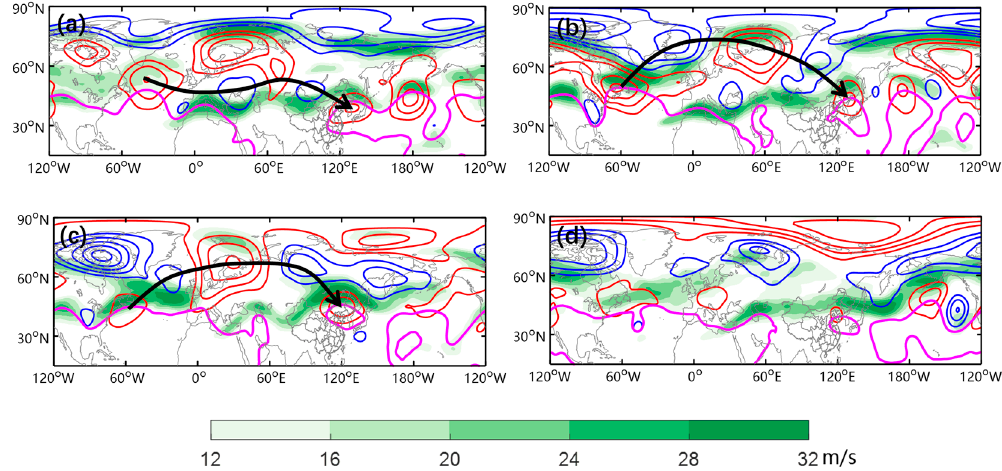
Figure 4. Composite 500 hPa geopotential height anomalies (contours; interval = 40; units: gpm), 300 hPa zonal wind (shading; units: m/s), 5880 gpm isoline (pink) for ( a ) hot period 1, ( b ) hot period 2, ( c ) hot period 3 and ( d ) hot period 4. The red (blue) contours address positive (negative) 500 hPa geopotential height anomalies. The thick black arrows denote the midlatitude wave train in ( a ) and the high latitude wave trains in (b) and (c).